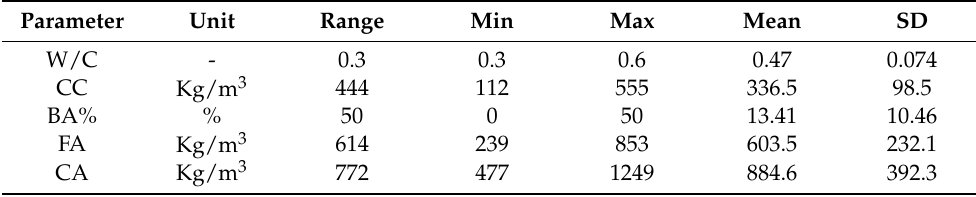
Table 2. Descriptive statistics of the input